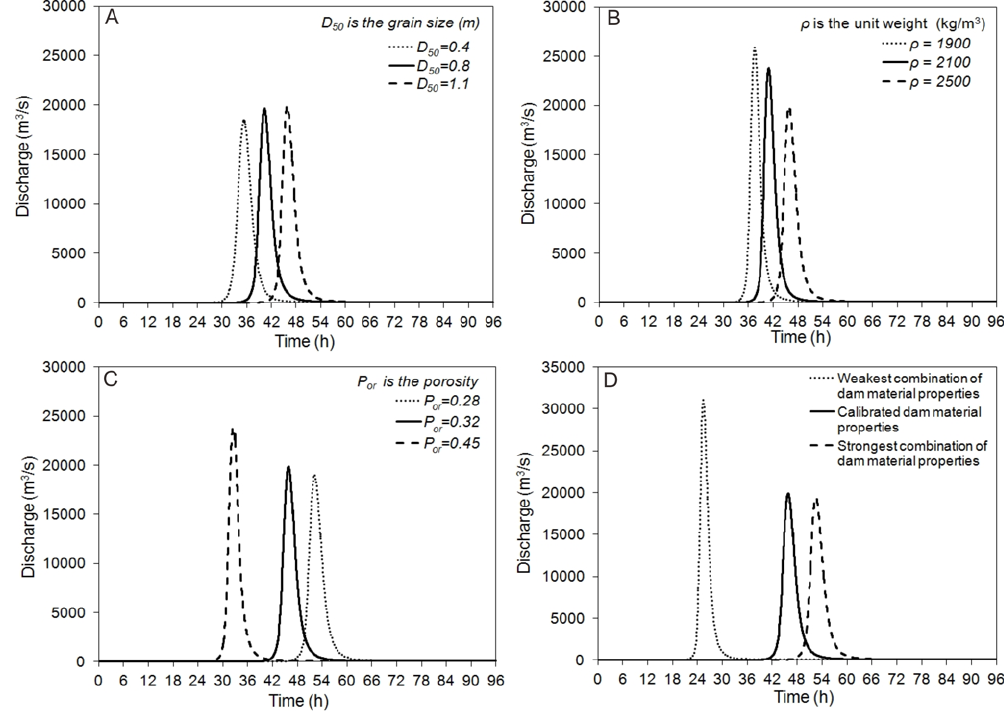
Fig. 10. Sensitivity analysis of the BREACH model outflow hydrograph to dam material properties ( A : D 50 grain size; B : dam material unit weight; and C : porosity) and uncertainty analysis of the BREACH model outputs (D) .